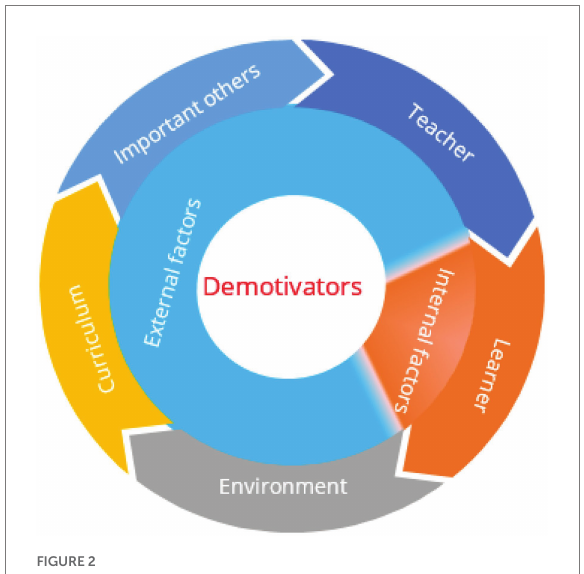
FIGURE 2 The classifications of